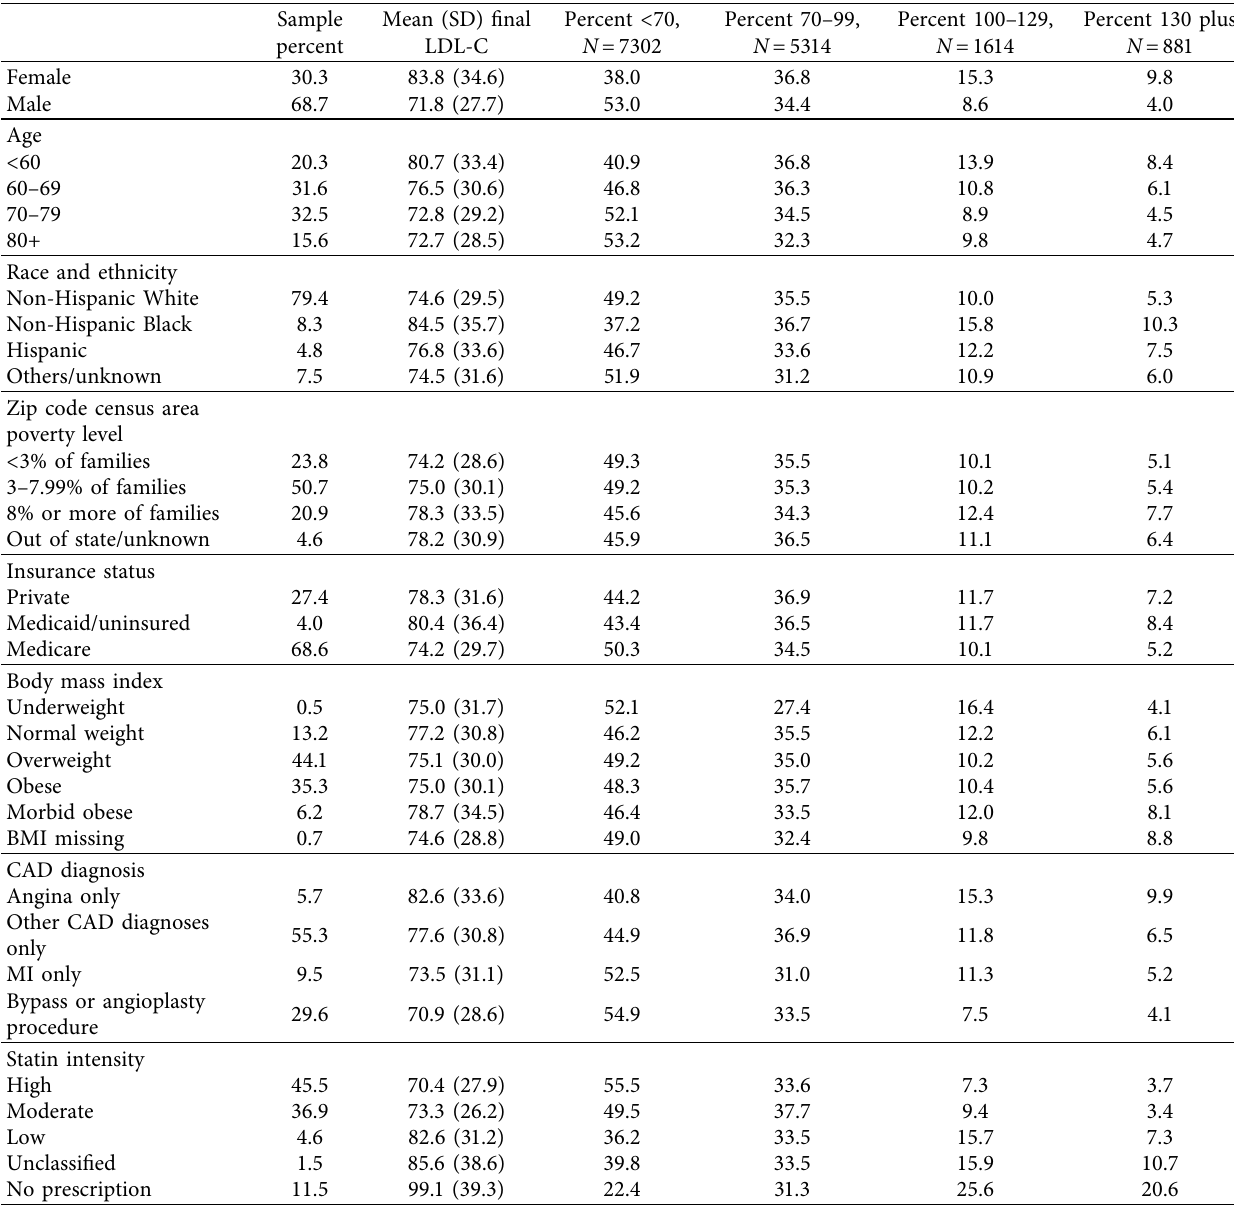
Table 1: Last measured low-density lipoprotein cholesterol mg/dl levels. N � 15,111 health system patients with documented coronary artery disease (CAD).